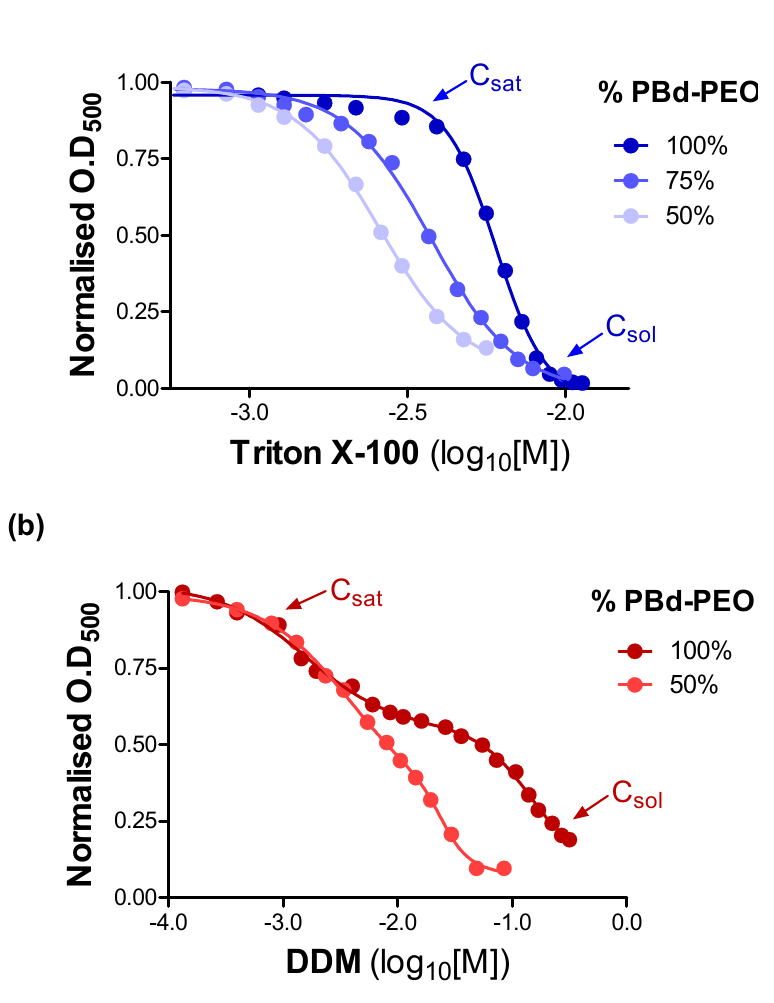
Figure 3. Solubilisation of vesicles containing varying proportions of PBd-PEO by the detergents Triton X-100 (TX-100) and dodecyl-maltoside (DDM). Absorbance (optical density (OD)) of vesicles was measured at 500 nm in a 1 cm path length quartz cuvette. Detergent was added and the signal was monitored continuously. All data were normalised to the optical density in the absence of detergent. The point of saturation with detergent (C sat ) and the point of solubilisation (C sol ) are shown for the highest polymer proportion in each panel for clarity. ( a ) Vesicles containing varying proportions of PBd-PEO (50%, 75%, and 100%) and EcCL were solubilised by the detergent Triton X-100. ( b ) Vesicles containing varying proportions of PBd-PEO (50% and 100%) and EcCL were solubilised by the detergent DDM.